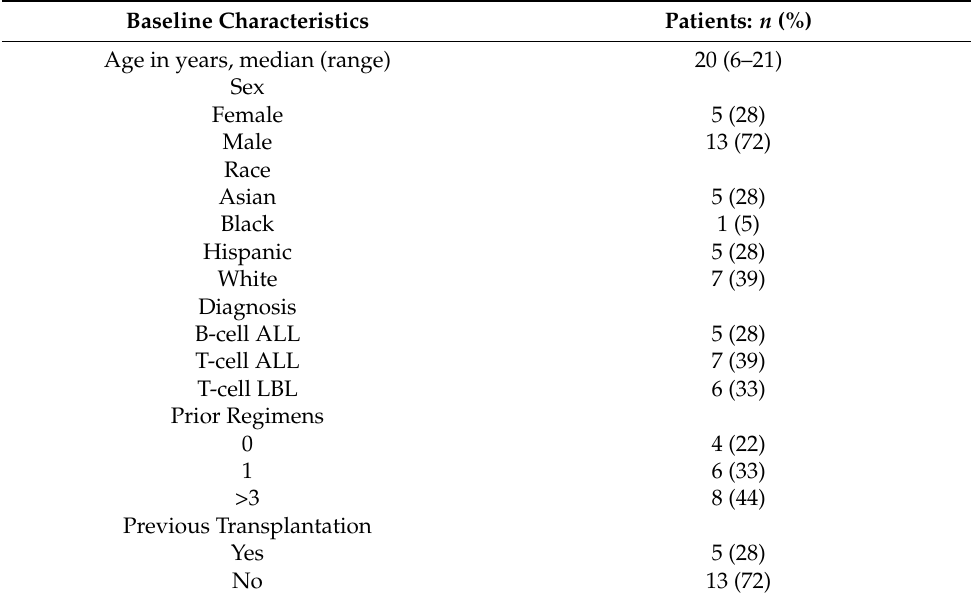
Table 1. Baseline patient demographics and number of prior